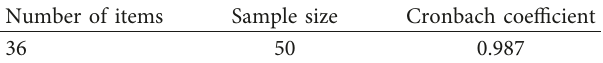
Table 8: Questionnaire survey reliability analysis results. Table 9: Revised questionnaire reliability analysis